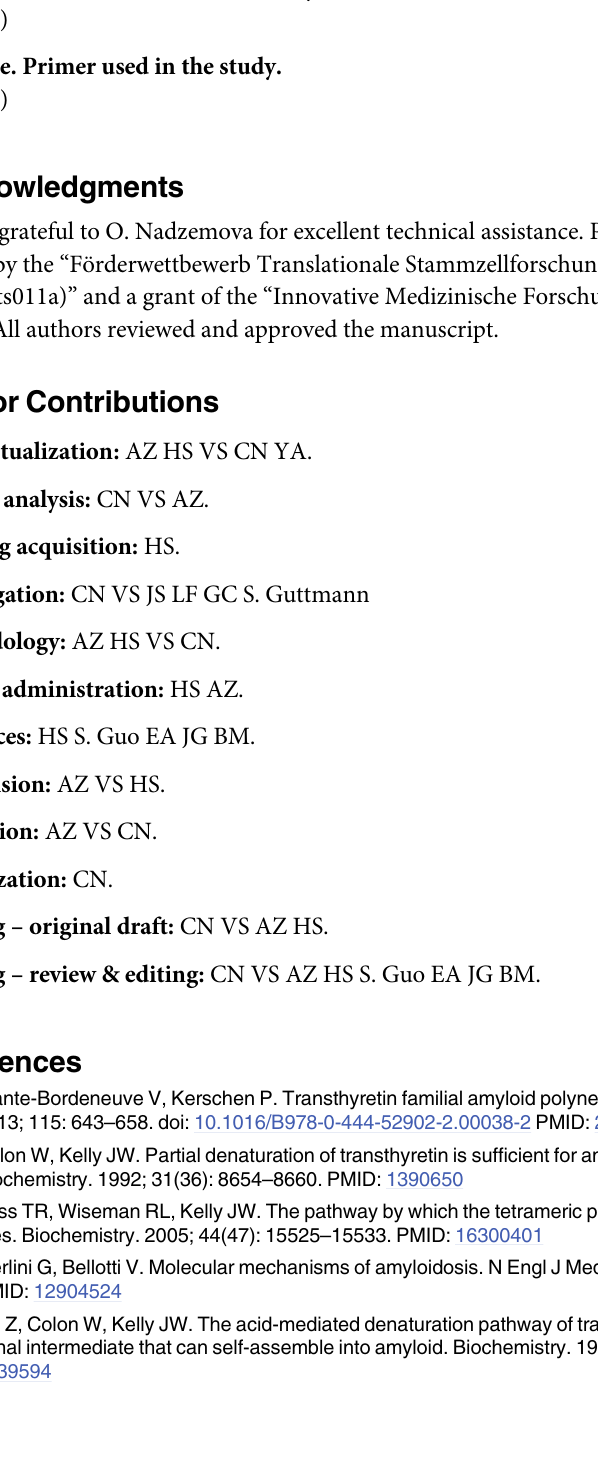
S5 Fig. Protein expression of marker genes following TTR knockdown. Immunocytochemis- try stainings of albumin and alpha-fetoprotein after treatment with compounds (24 h). One typical experiment derived from HLCs of FAP4 cell line is shown. Exposure time was adjusted to 1/3 second. Scale bars, 50 μ M. S1 Table. Antibodies used in the study. S2 Table. Primer used in the